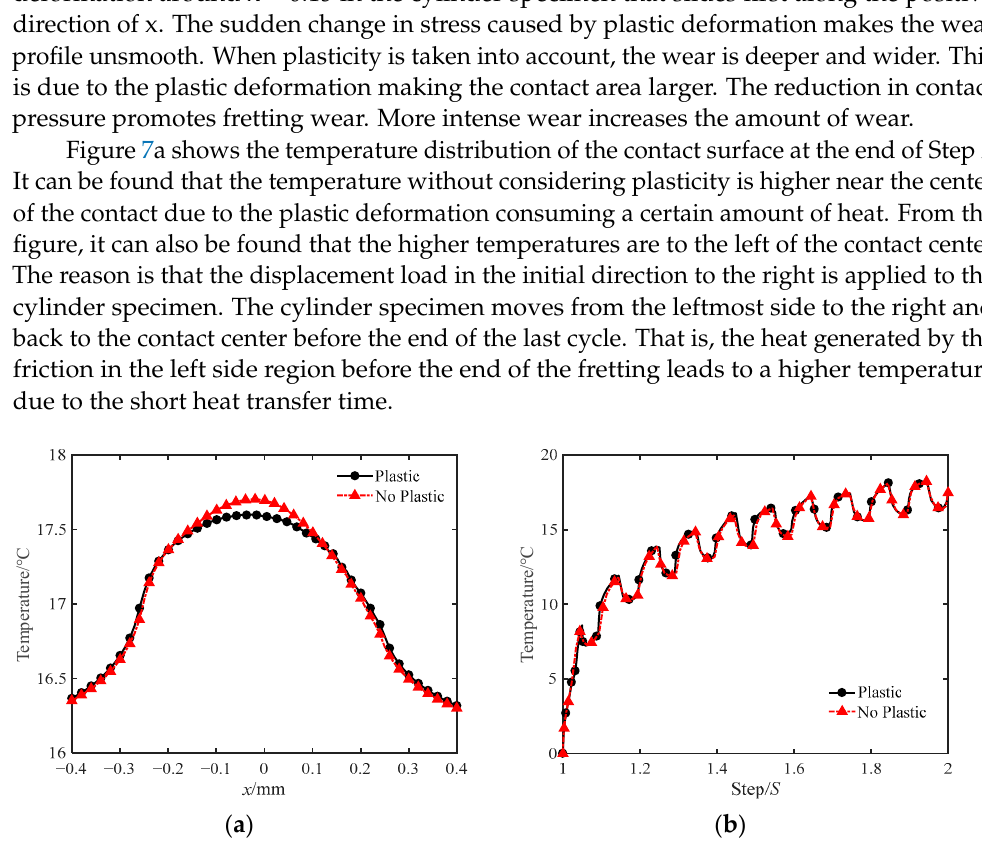
Figure 7. Temperature distribution when considering plasticity. ( a ) Temperature distribution; ( b ) variation pattern of temperature.